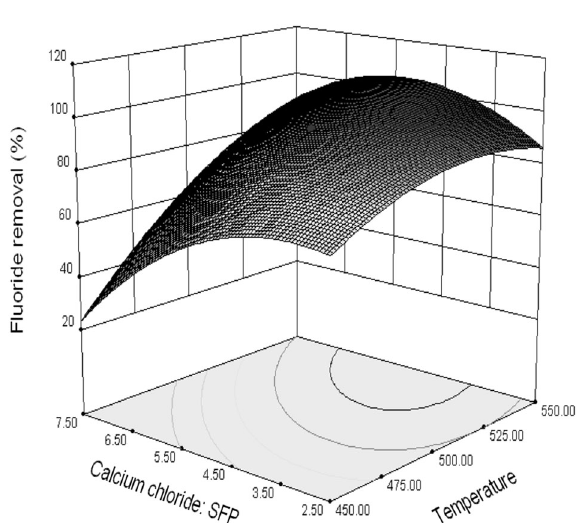
Fig. 1 Response surface diagram of conjugated effect of temperature of carbonization and weight ratio of calcium chloride and SFP for preparation of CCSFP